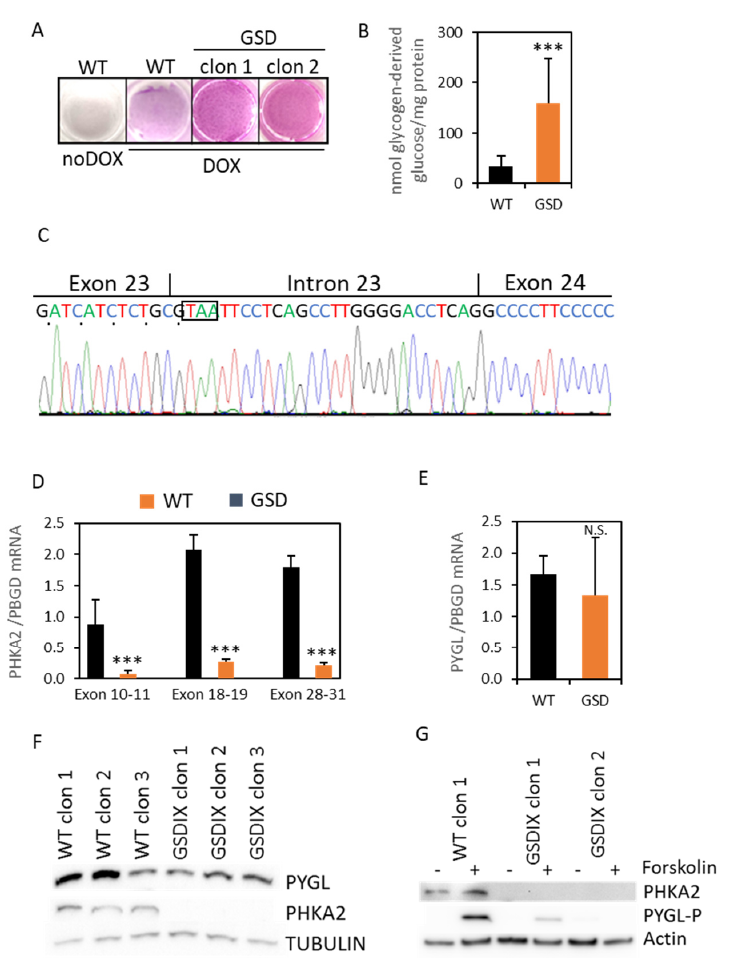
Figure 3. Characterization of the GSD-IX phenotype. The iHDF-T GSD were reprogrammed into the diHLC-T GSD by incubation in HMM media containing 250 ng/mL of DOX for 12 days. ( A ) PAS staining. ( B ) Quantification of intracellular glycogen in the mutant diHLC-T GSD . The glycogen content is expressed as nmol of glucose released from the glycogen digestion with α -amyloglycosidase. ( C ) Sanger sequencing of the PCR-amplified cDNA across the exon 23–24 junction showed an additional twenty-seven base pair insertion in the patient cells compared to the reference sequence. The in-frame STOP codon is boxed. ( D , E ) Expression of the PHKA2 mRNA, measured by RT-qPCR using primers designed in exons 10–11, 18–19, and 28–31. The expression of the PYGL mRNA is also shown. The values depicted correspond to the average of three different clones of reprogrammed diHLC-T and diHLC-T GSD . All values correspond to average plus standard deviation. ( F ) Western blot analysis of PYGL and PHKA2 in diHLC-T and diHLC-T GSD . ( G ) Western blot analysis of PHKA2- and Ser15-phosphorylated PYGL in diHLC-T and diHLC-T GSD with and without forskolin. ***, p < 0.005; N.S., not